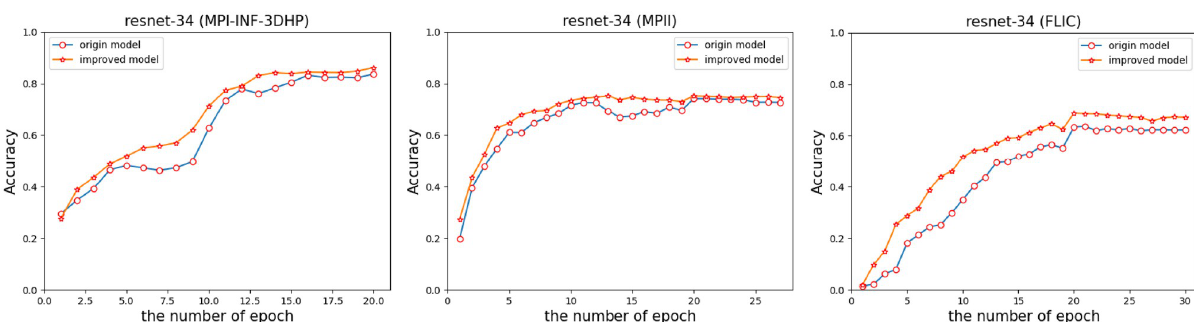
Fig 8. Comparative experiment results between RDNS network (the network is represented as an improved model) and Resnet-34 network.